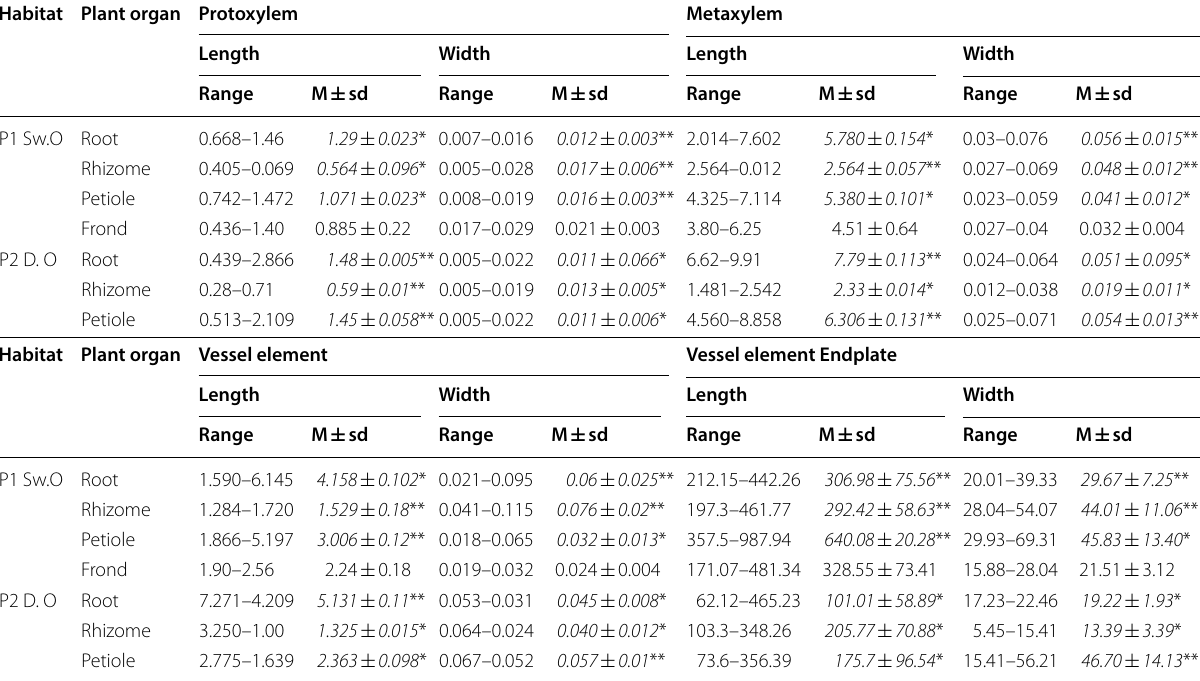
Table 3 Tracheary elements and vessel member end wall length–width(s) of Thelypteris interrupta from different population